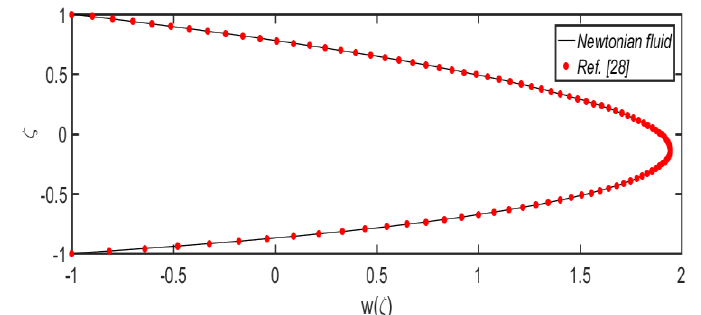
Figure 2. Validation of numerical results with Tanveer et al. [28].